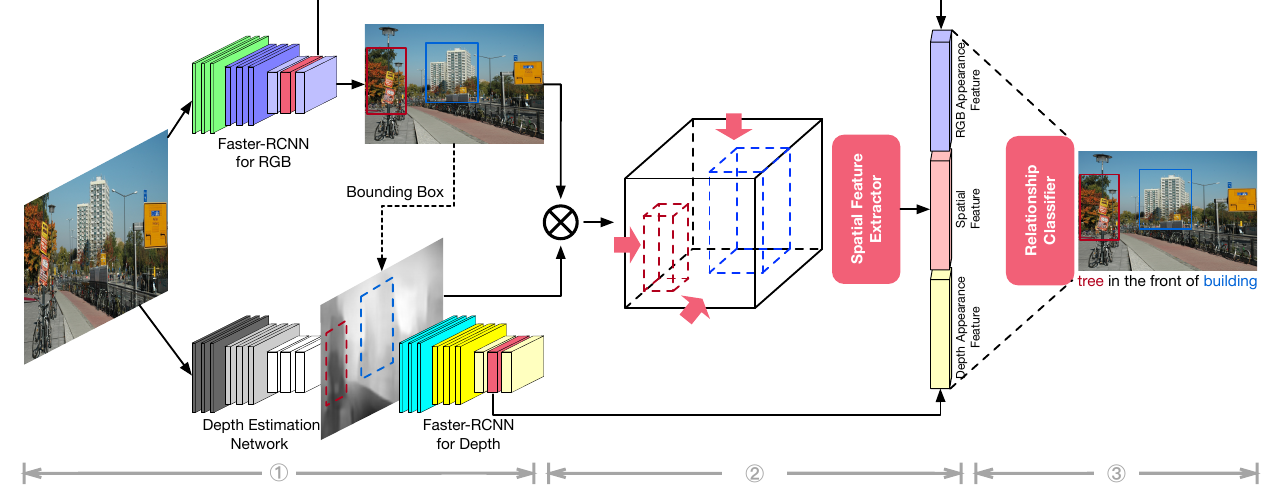
Figure 2. An overview of the proposed multi-view visual relationship detection framework. This framework is composed of three main modules: (1) RGB-D object detector. For a monocular RGB image, first it is input into a depth estimation network [18] to obtain the corresponding depth map. Then, the original RGB and generated depth map are input into two different Faster-RCNNs [22] to locate and classify objects. (2) Multi-view features generator. After obtaining the locations of objects in the RGB image and estimated depth map, multi-view images (front view, left view and top view) are generated by specific strategies. Then the spatial feature vector is extracted by an extractor. Moreover, the RGB and depth appearance feature vector are both concatenated with a spatial feature vector. (3) Visual relationship classifier. The concatenated final feature vector is input into a visual relationship classifier to predict the visual relationship